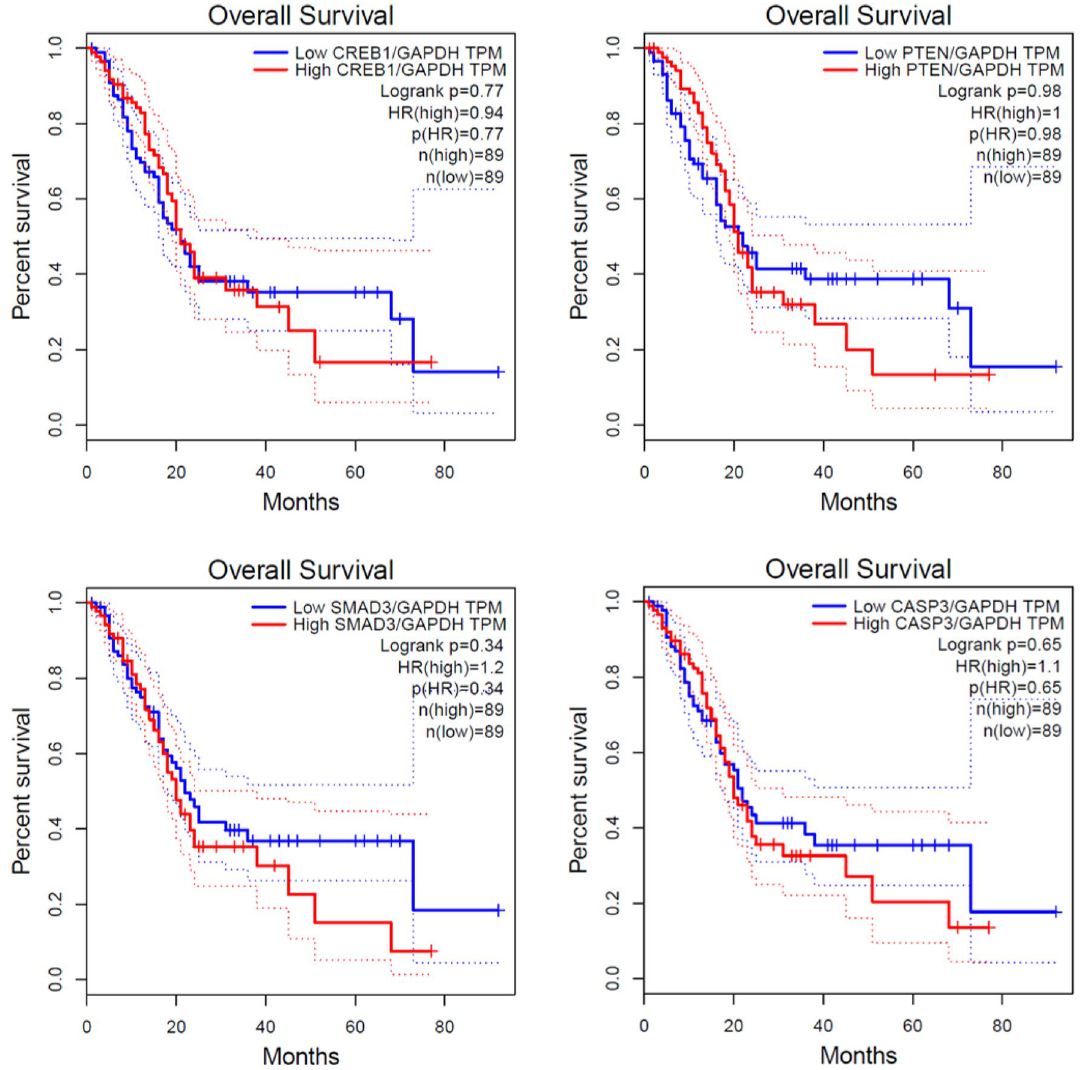
Figure 7. The Kaplan–Meier curves of candidate genes based on TCGA data. The TCGA database illustrated the impact of CREB, PTEN, SAMD3, CASP3 genes on overall survival rate of patient with pancreatic adenocarcinoma. All four graphs contain blue (low TPM) and red (High TPM) line which normalized by